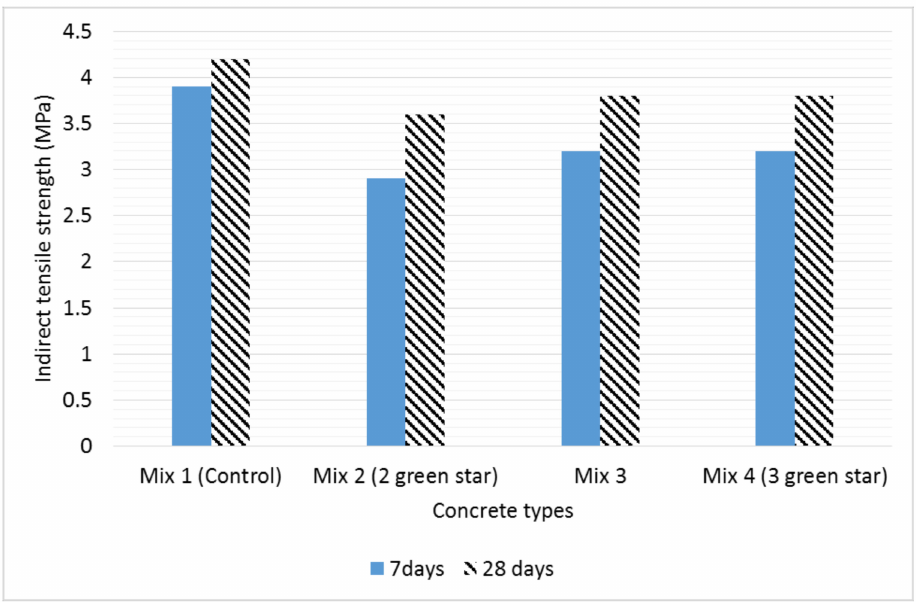
Figure 5. Measured indirect tensile strength of green star concretes and control concrete.